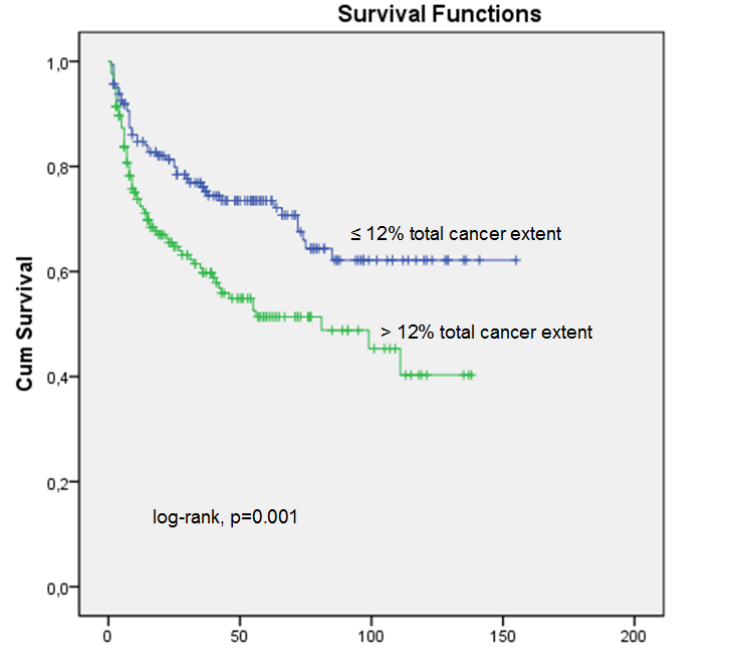
Figure 1 - Kaplan-Meier product-limit analysis shows time to PSA biochemical progression-free outcome by the median value of percentage of cancer extent in mm in all cores. Cum ,